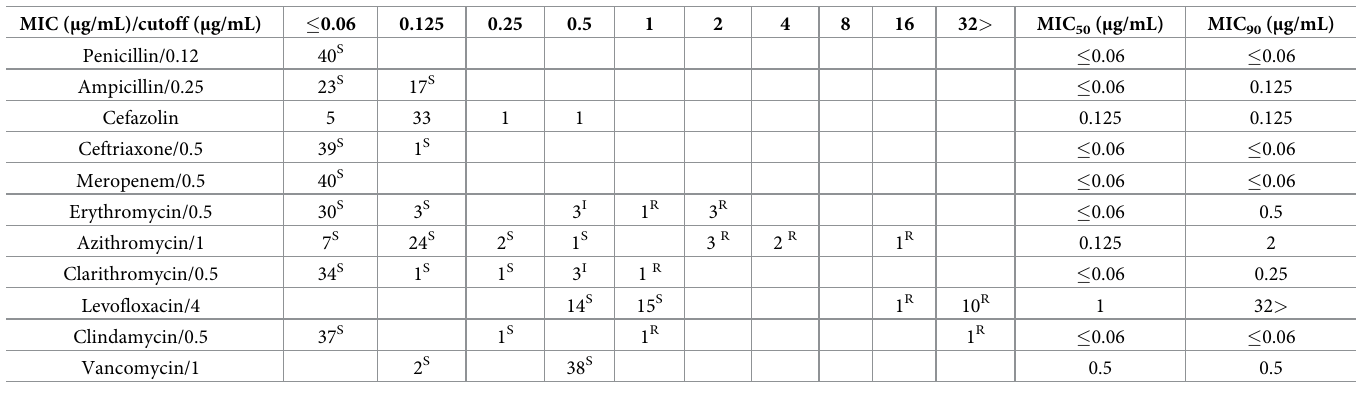
Table 4. Number of GBS isolates by the minimum inhibitory